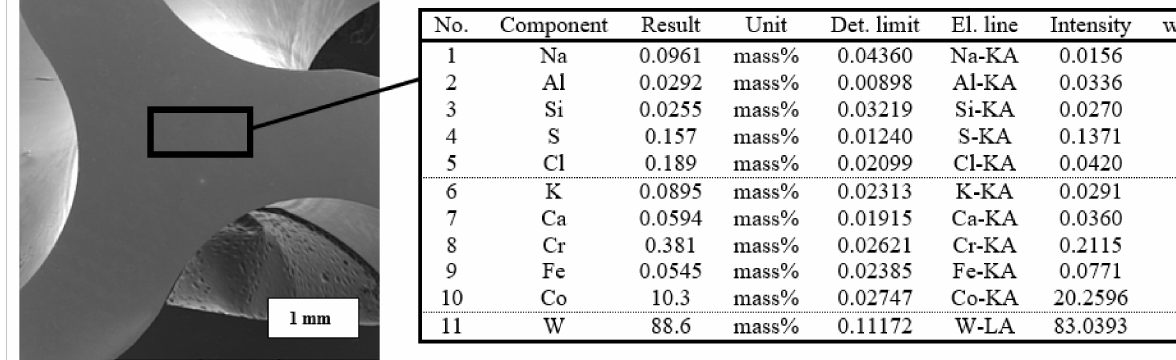
Figure 4. Area of the tool core examined by XRF and its elemental representation of the tool material.